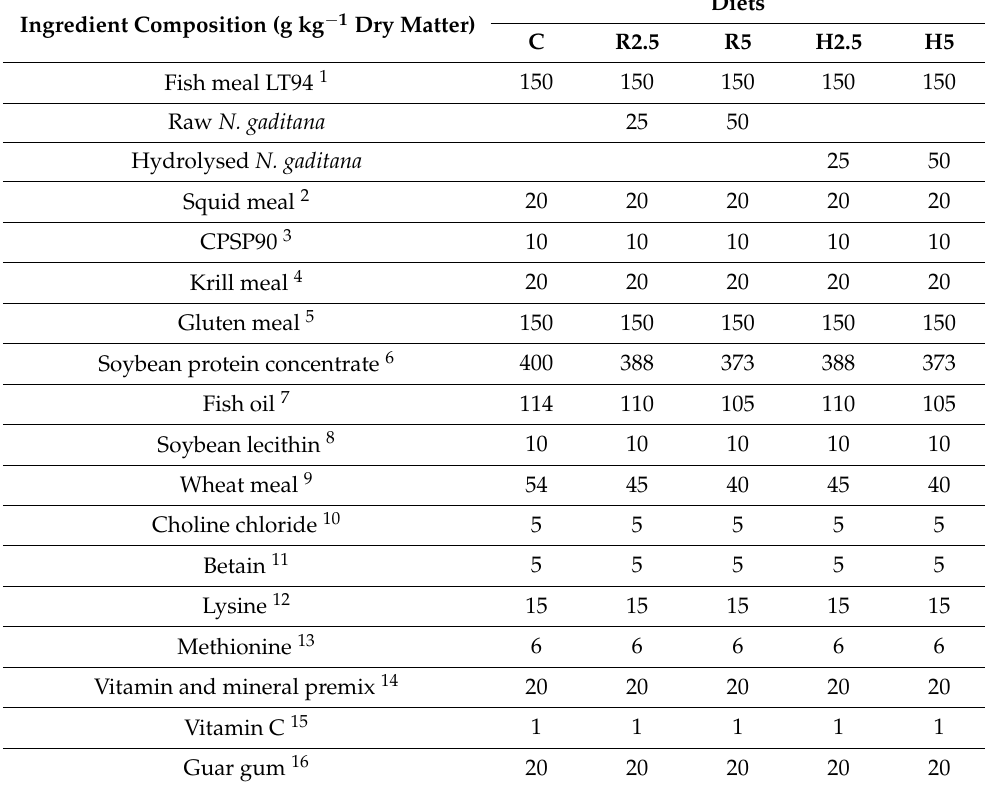
Table 1. Ingredient composition of the experimental diets that were used during the juvenile period of sea bream specimens of the present work. Data are expressed in g kg –1 dry